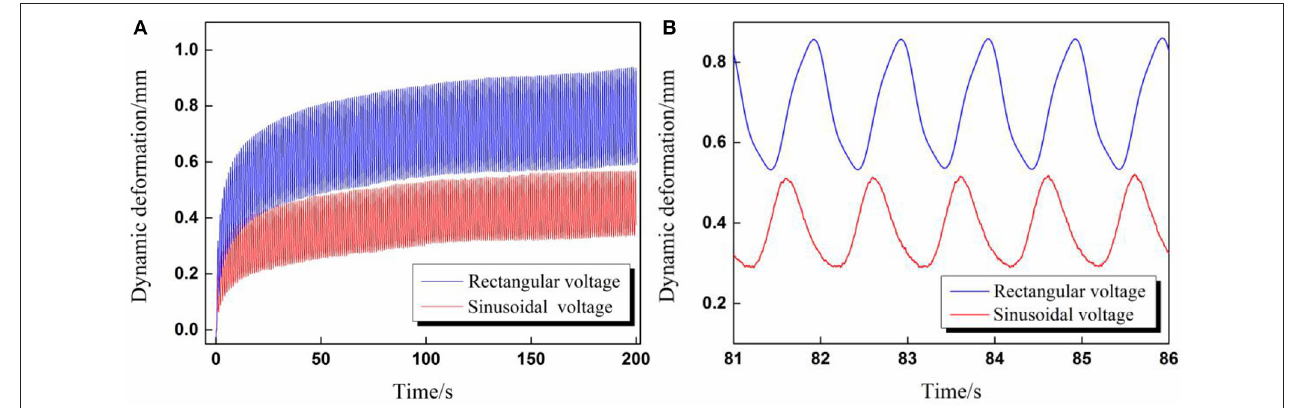
FIGURE 5 | (A) The overall comparison diagram of dynamic deformation curves excited by rectangular and sinusoidal voltage; (B) Partial enlarged view of dynamic deformation curves for five cycles (Voltage amplitude 6 kV, voltage frequency 1Hz, A/D ratio β = 1).